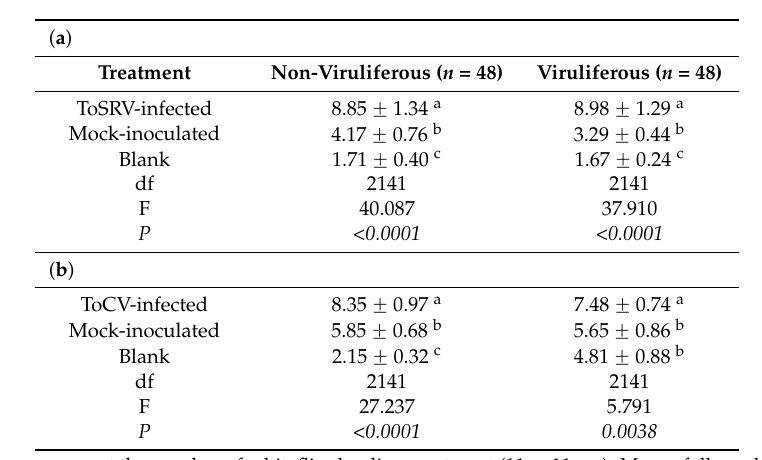
Table 1. Mean ˘ SE number of whiteflies* landing on ( a ) Tomato chlorosis virus (ToSRV)-infected and ( b ) Tomato severe rugose virus (ToCV)-infected tomato leaves, mock-inoculated tomato leaves, and brown background (blank) 6 h after release from the launch platform. Plexiglass sheets containing a coating of mineral oil were placed on top of the leaves to provide a uniform landing surface (65 ˆ 65 cm) and avoid the confounding effects of leaf olfactory cues. Each assay was repeated four times.